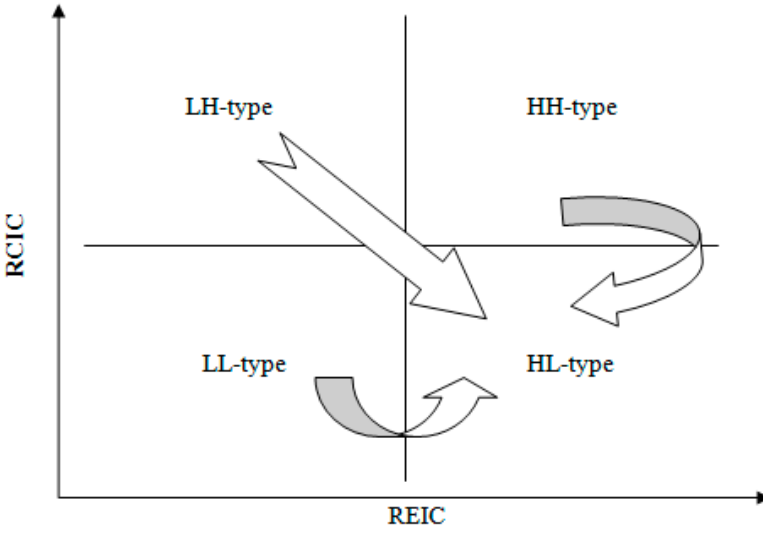
Figure 3. Policy implications for different types of sectors or regions.